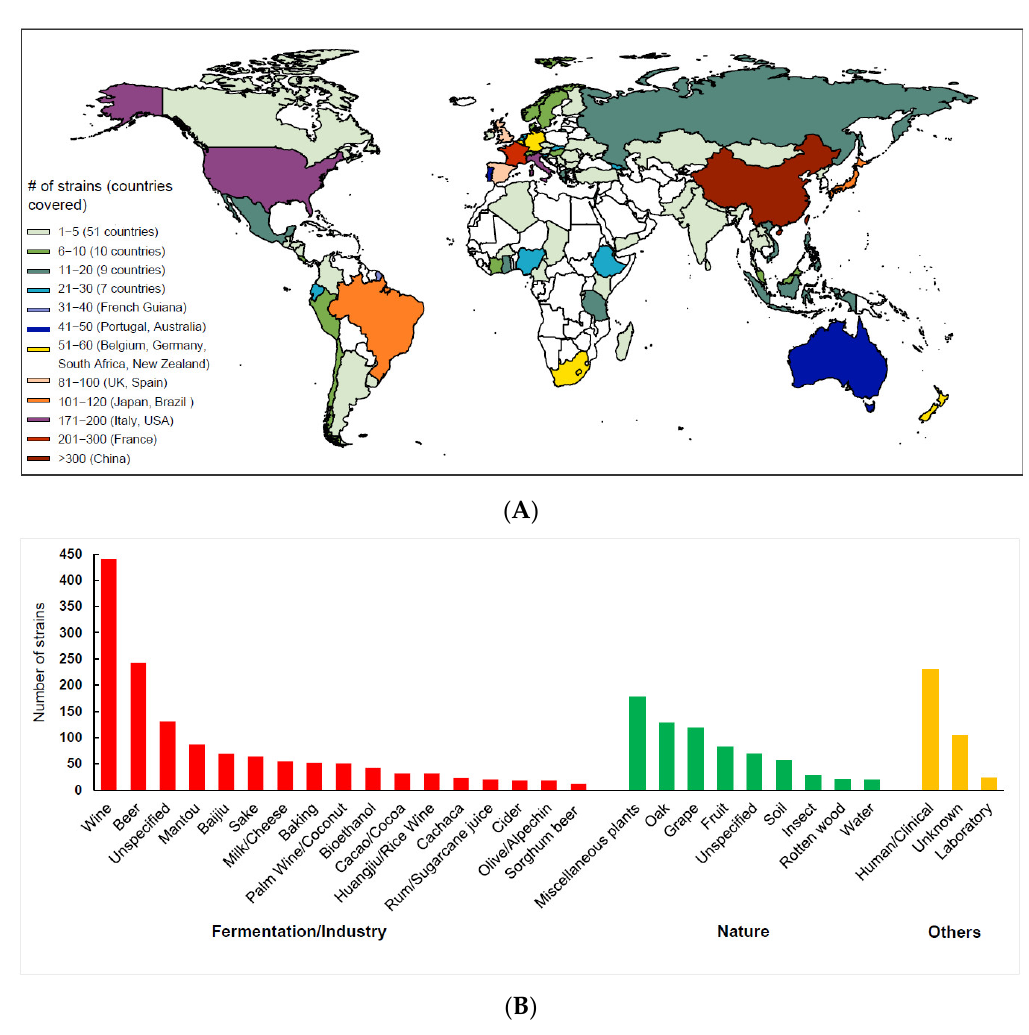
Figure 3. Geographic ( A ) and ecological ( B ) origins of the S. cerevisiae strains with their genome sequences available to the public.